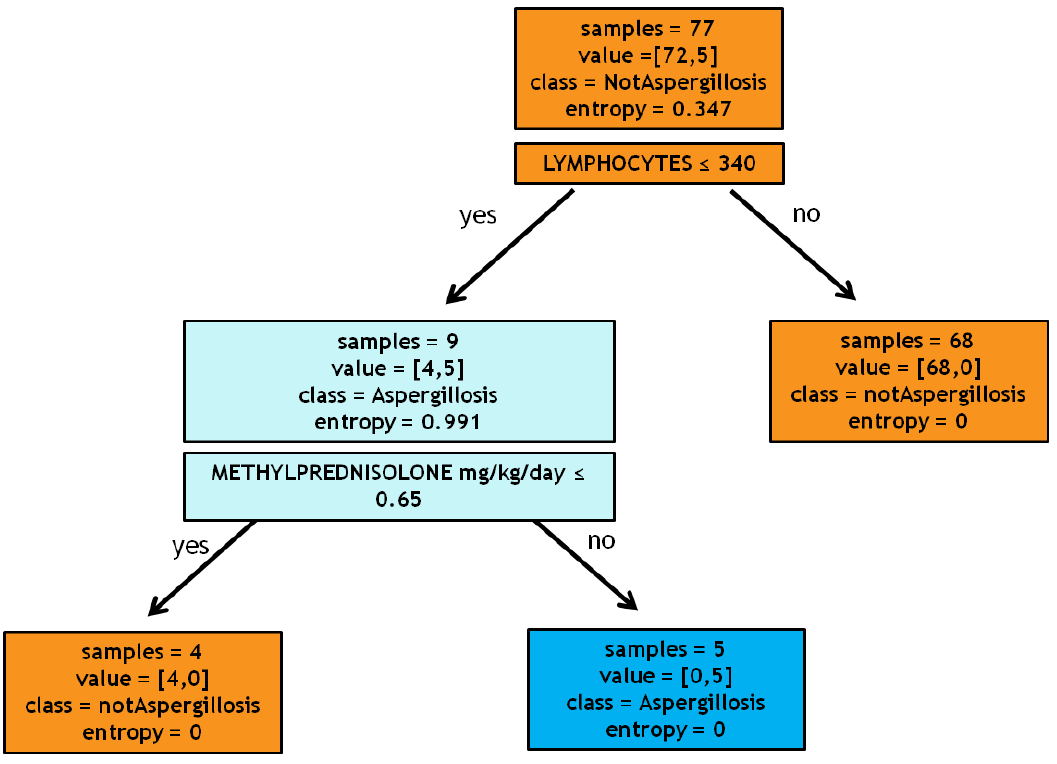
Figure 1. Decision tree.